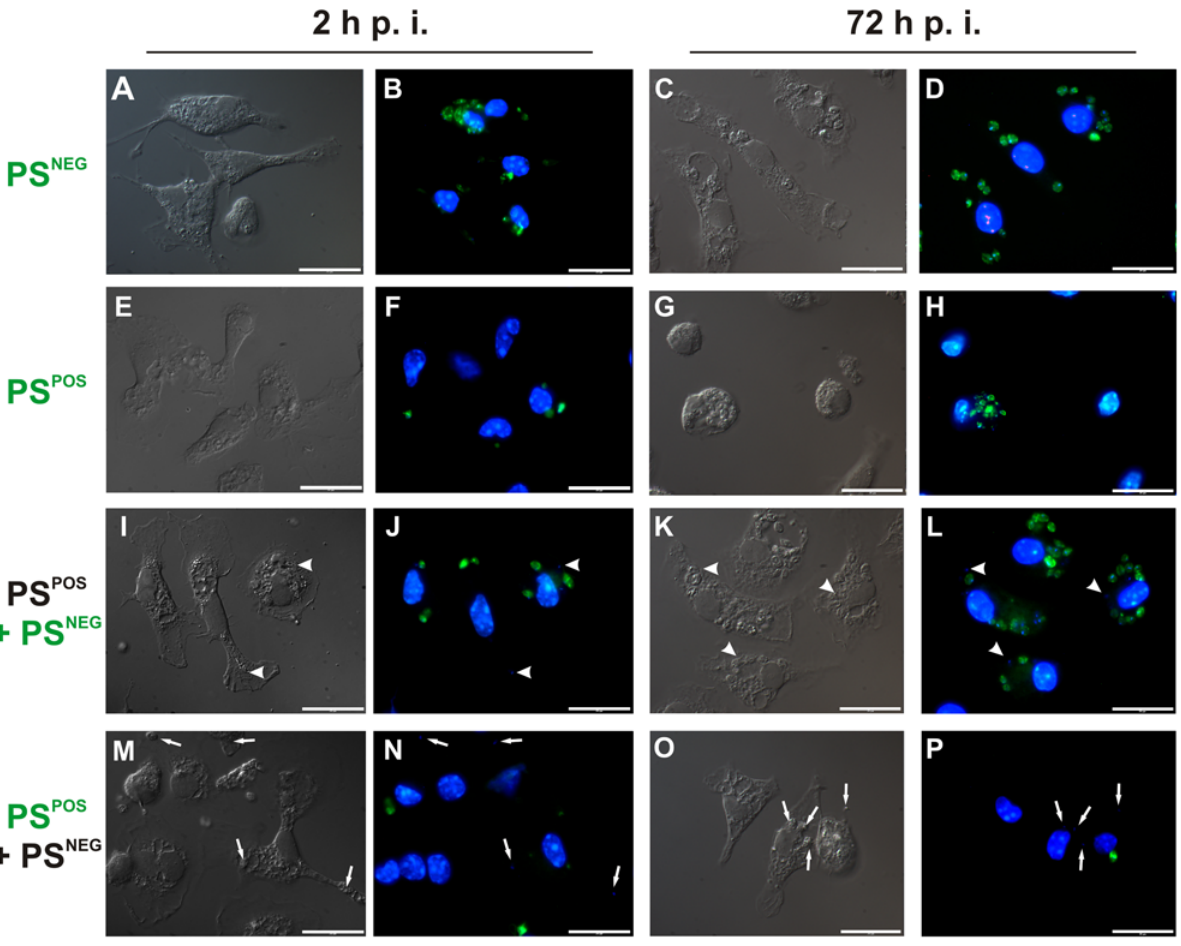
Figure 3. Purified PS POS promastigotes are required for the invitro infectivity of PS NEG forms. Differential interference contrast (left panels) and fluorescence microscopy (right panels) at 2 h and 72 h p. i. of macrophage monolayers infected with CFSE-treated purified PS POS , PS NEG and PS POS + PS NEG (reconstituted at a 1:1 ratio) population of promastigotes. Arrowheads indicate PS POS CFSE-unlabeled parasites stained with DAPI (panels J and L). Arrows indicate PS NEG CSFE-unlabeled parasites stained with DAPI (panels N and P). Nuclei are stained with DAPI. Bars represent 20 m m. Figure displays one experiment out of two with similar results.